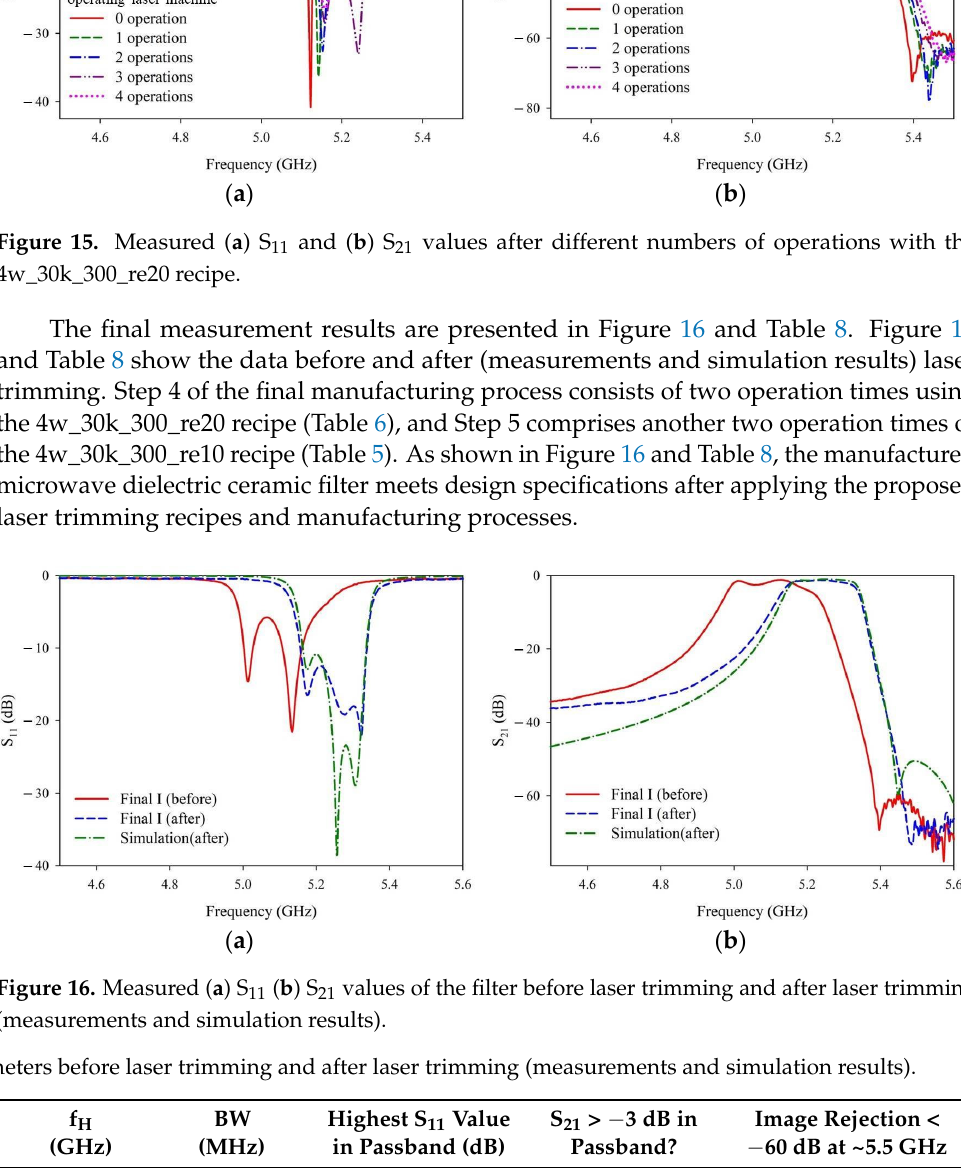
Figure 15. Measured ( a ) S 11 and ( b ) S 21 values after different numbers of operations with the 4w_30k_300_re20 recipe. The solid red curves represent ceramic filter samples without laser trimming. Figures